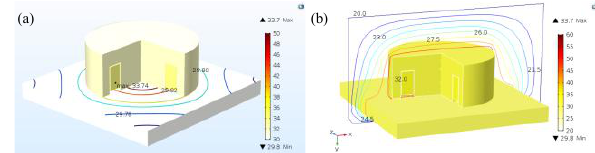
Fig. 2. Thermal field distribution of (a) gripper and attracted surface and (b) the air surrounding the object for current value of I=0.2 A.